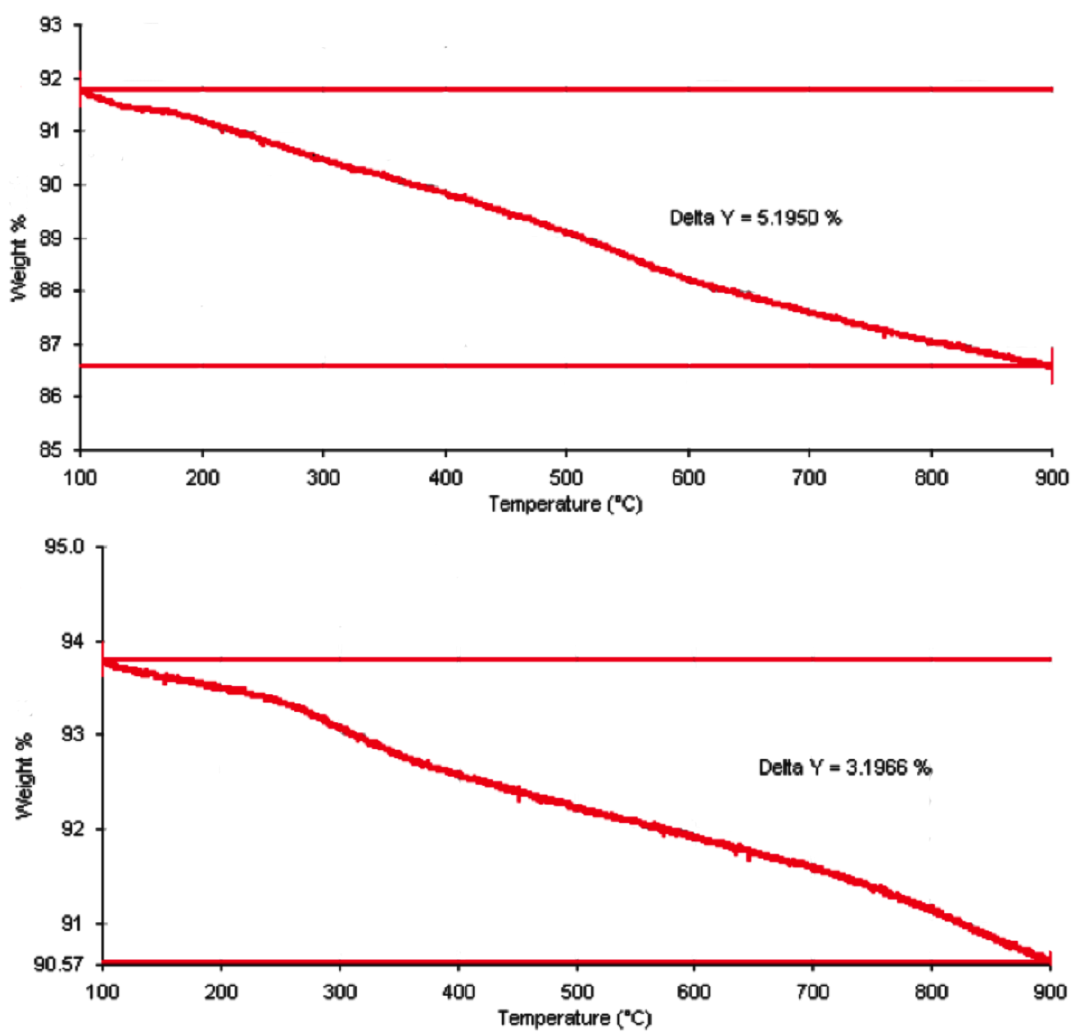
Figure 1. The thermogravimetric analysis on the weight losses of nanoparticle-encapsulated Scutellaria baicalensis (Nano-SB) (5.2%) ( upper ) and blank nanoparticles (3.2%) ( lower ) between 100 °C and 900